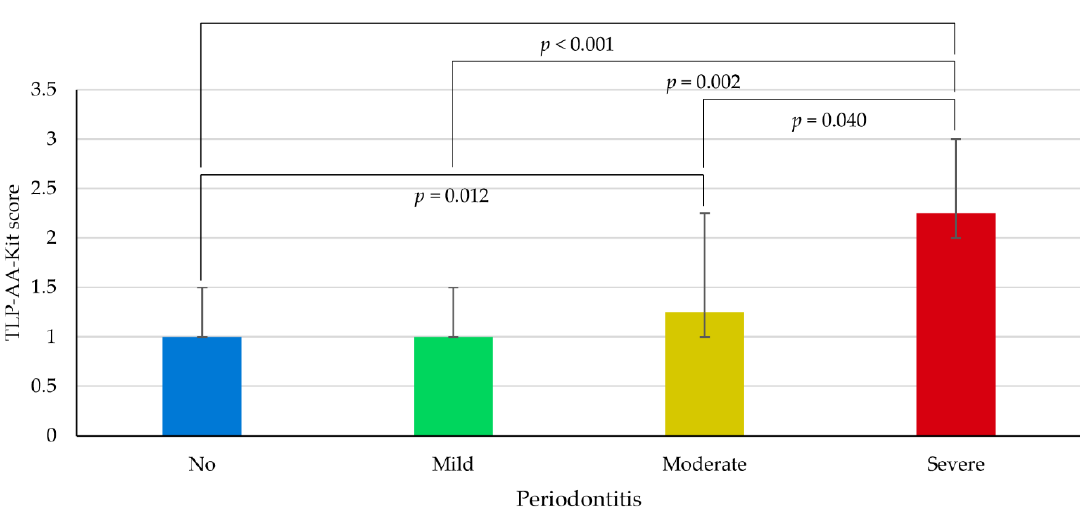
Figure 2. TLP-AA-Kit scores according to periodontitis classification.